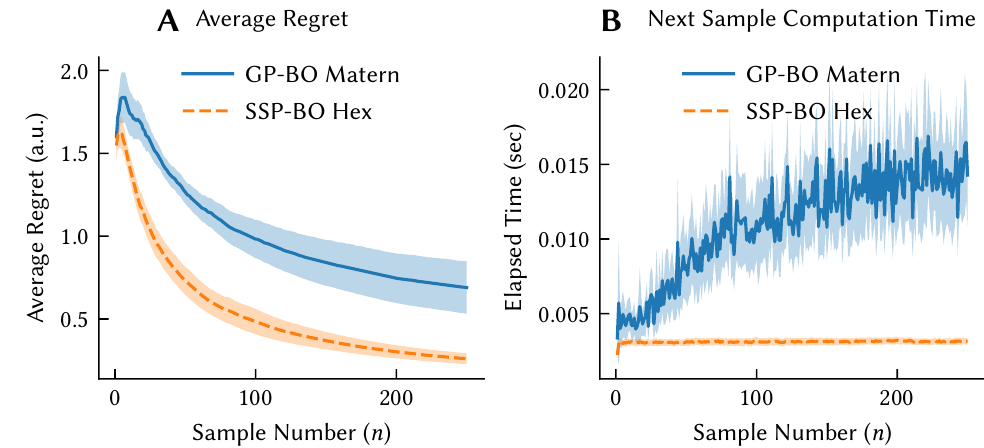
Figure 15. The regret performance of Bayesian optimization implemented using Gaussian processes with a Matern kernel (GP-BO Matern) and implemented using the Hexagonal Spatial Semantic Pointer representation (SSP-BO Hex) on the Himmelblau standard optimization test function ( A ). The regret performance of SSP-based algorithms is statistically equivalent to the GP methods, however, by working in the neurally-plausible feature spaces, the computation time becomes constant in the number of samples collected ( B ). Figured adapted from